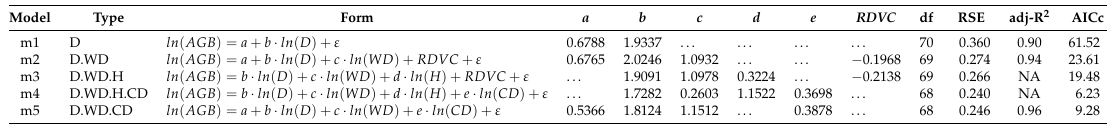
Table 3. Models description for the TLS-derived aboveground biomass estimations including diameter ( D ), wood density ( WD ), height ( H ), crown diameter ( CD ), Reference Dummy Variable Corrector ( RDVC ) and associated statistical parameters based on 72 trees.